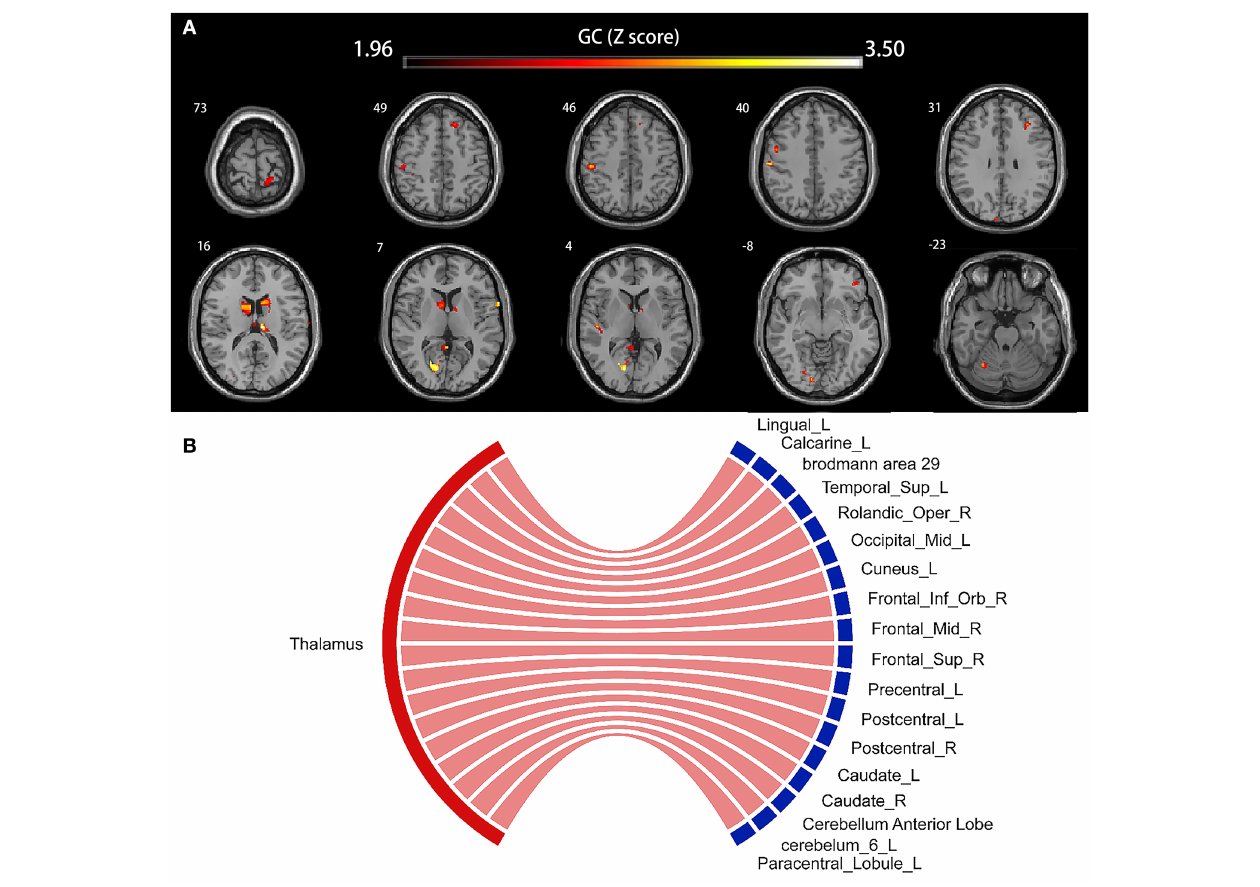
FIGURE 4 | Voxel-based causal network of structural covariance (CaSCN). Thalamus swelling had causal effects on the left lingual gyrus, the left calcarine sulcus, Brodmann area 29, left middle occipital gyrus, left cuneus, left superior temporal gyrus, right Rolandic operculum, right frontal inferior operculum, right frontal middle gyrus, right frontal superior gyrus, left precentral gyrus, left paracentral lobule, bilateral postcentral gyrus, bilateral caudate nucleus, bilateral thalamus, and cerebellum ( p < 0.05, corrected). Significant regions were overlaid onto the Montreal Neurological Institute (MNI) template, and the Granger causality value is represented by the colors shown in the color bar (A) . The Sankey and Chord were also used to display the causal effects intuitively (B) ; the flow from the bilateral thalamus (red label) to the thalamus-affected regions (blue label) is colored in red according to the positive causal effects. GC, Granger causality; L, left; R, right; Sup, supper; Oper, opercularis; Mid, middle; Inf, inferior; Orb,